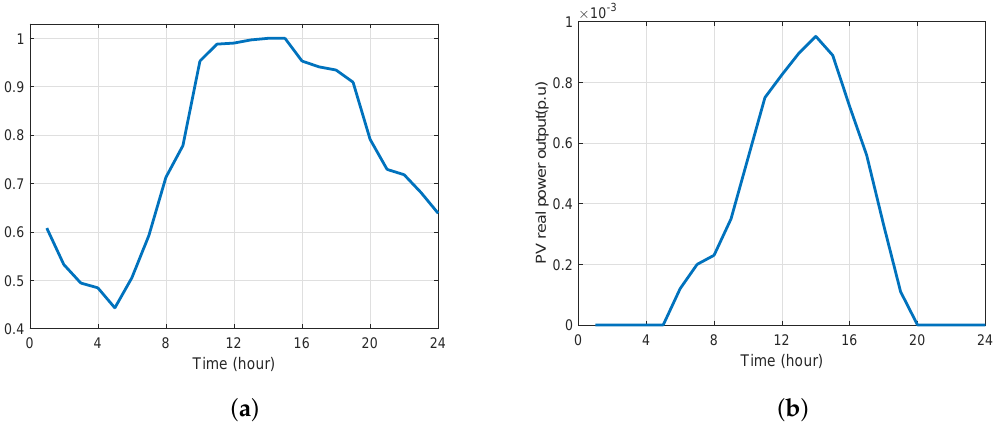
Figure 4. Profile of the predicted value with a resolution of 1 h for: ( a ) load coefficient; ( b ) PV real power